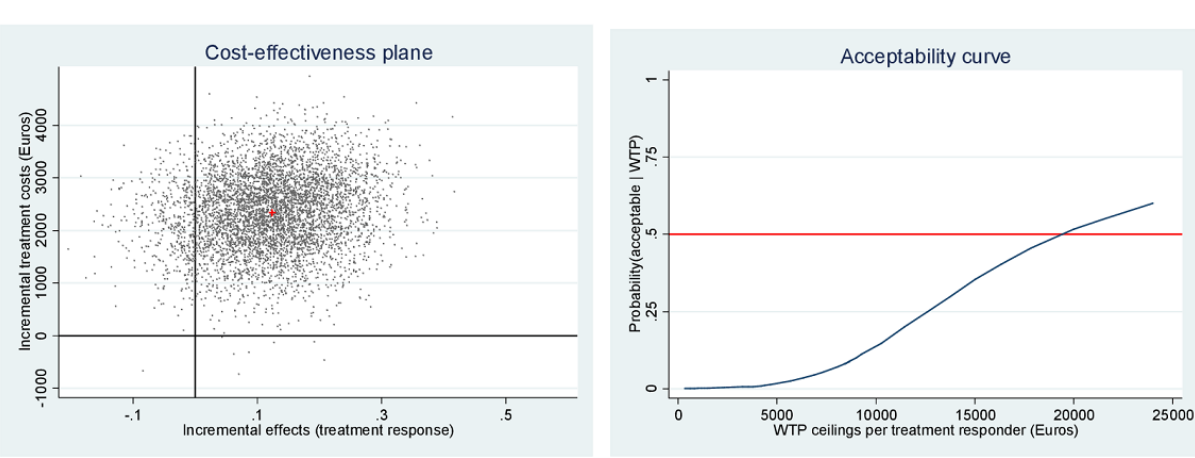
Figure 3. Cost-effectiveness plane and willingness to pay (WTP) acceptability curve for momentary anxiety.